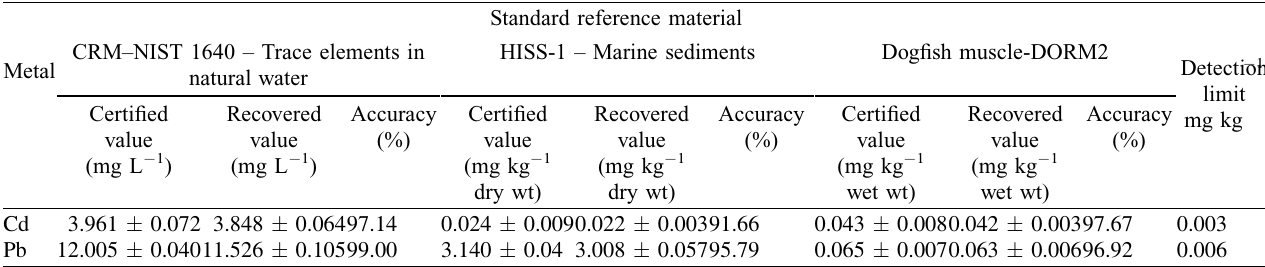
Table 1. Cadmium and lead concentrations in certi fi ed reference materials, and accuracy and detection limits determined by ICP-MS analyses.